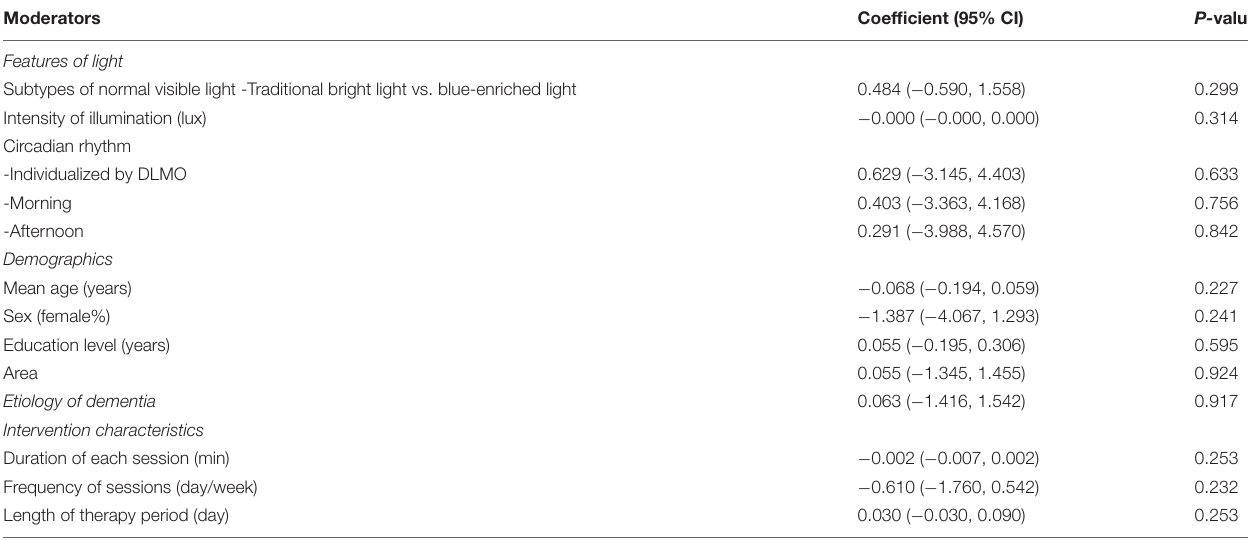
TABLE 2 | Summary of univariate meta-regression analyses for global cognitive function in relationship to normal visible